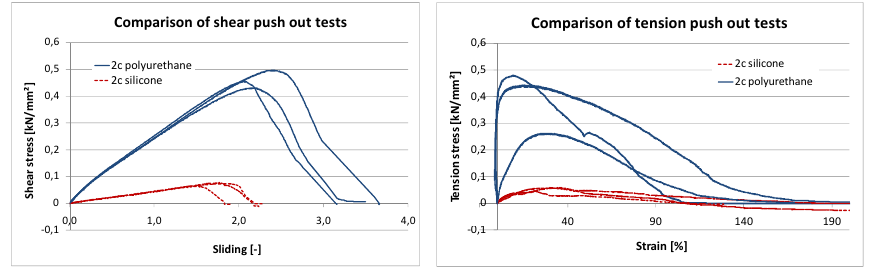
Figure 6a and b: Comparison of shear (left) and tension tests (right) on push out specimen bonded with a two-component silicone (red dashed, K07) and a two-component polyurethane (blue,